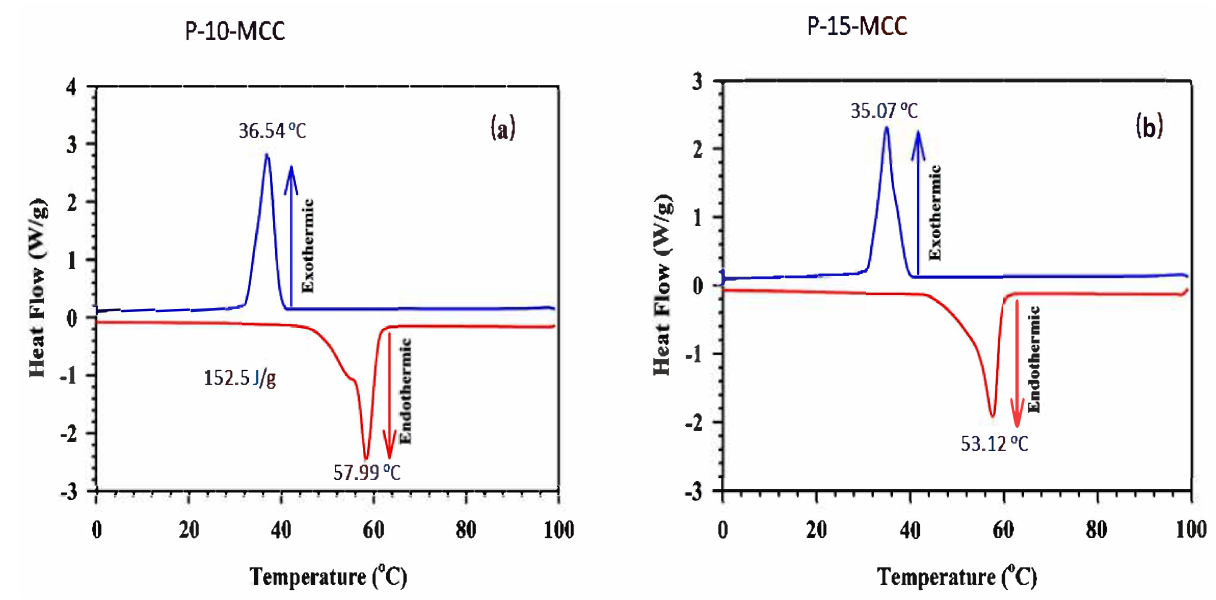
Figure 10. Melting–freezing DSC curves of ( a ) P-10-MCC, and ( b ) P-15-MCC PCM samples. The composite samples P-5-MCC, P-10-MCC, and P-15-MCC display an apparent melting enthalpy (computed considering the mass of the matrix) [13] or impregnation ratio (R) [22] of 70.94%, 80.43%, and 66.09%, respectively. These results can be explained in terms of the heterogeneity of the composites, in which the mixing and/or penetration of PEG is less than optimal. The validity of the assumption is confirmed by the small peaks of melting and solidification (Figure 9b). For comparison purposes, the DSC data of PEG/mesoporous calcium silicate (MCS) ss-PCM are included in Table 1. The latent heat of the composite denoted ss-CPCM4 matches the highest latent heat achieved for PEG/MCS composites (Table 1). Also, the PEG to support matrix ratio of about 7:3 of the PEG6000/MCS composites is similar to that of the composites used in this study. All parameters were calculated using the standard formulation (see below) [22].